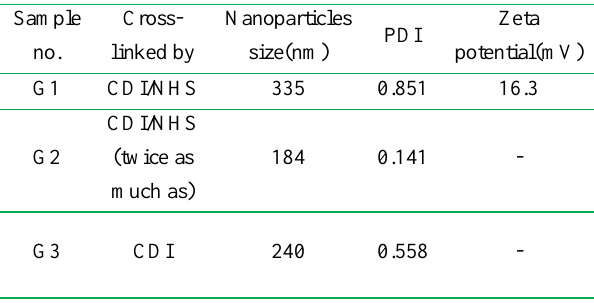
Table 1. Effect of type of cross-linking agent on size and PDI of nanoparticles.